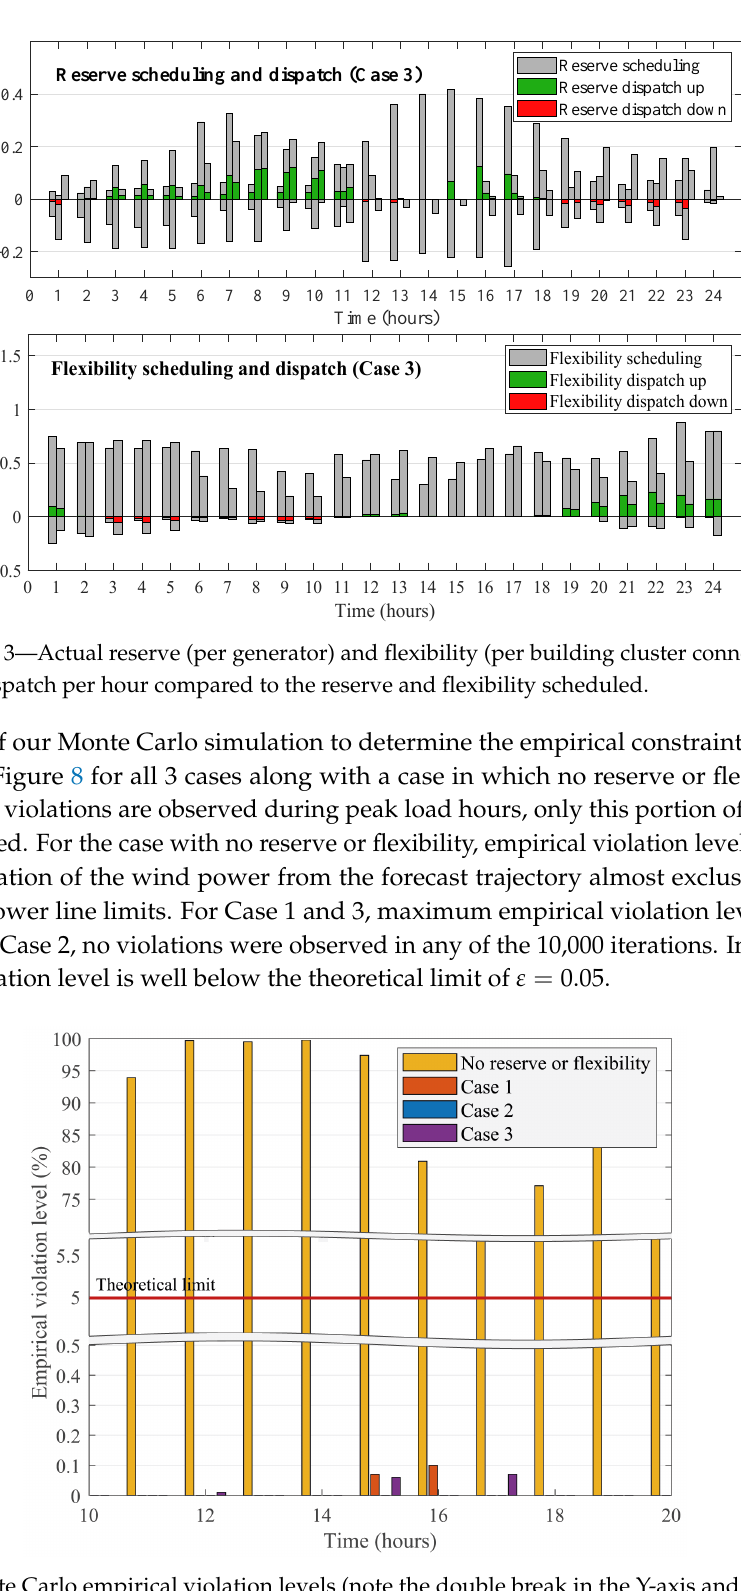
Figure 8. Monte Carlo empirical violation levels (note the double break in the Y-axis and the limited time span of the